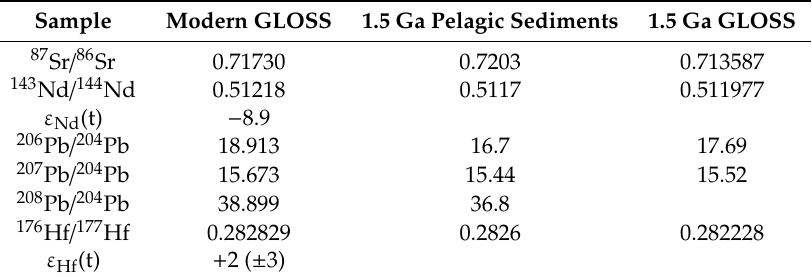
Table 2. Sr, Nd, Pb, and Hf isotopes of three endmember components.